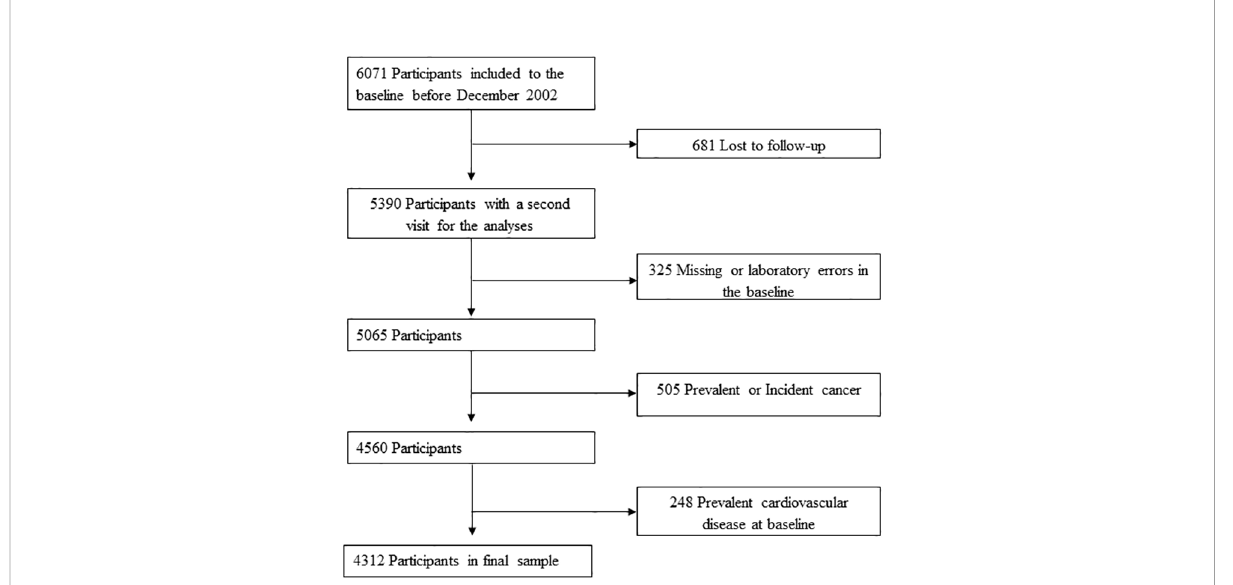
FIGURE 1 Flowchart of study participants drawn from the Vascular-Metabolic CUN cohort between 1997 to